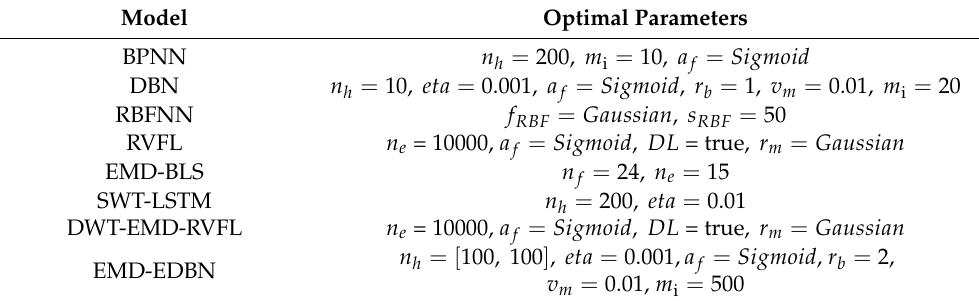
Table 1. Comparison of method parameter settings.